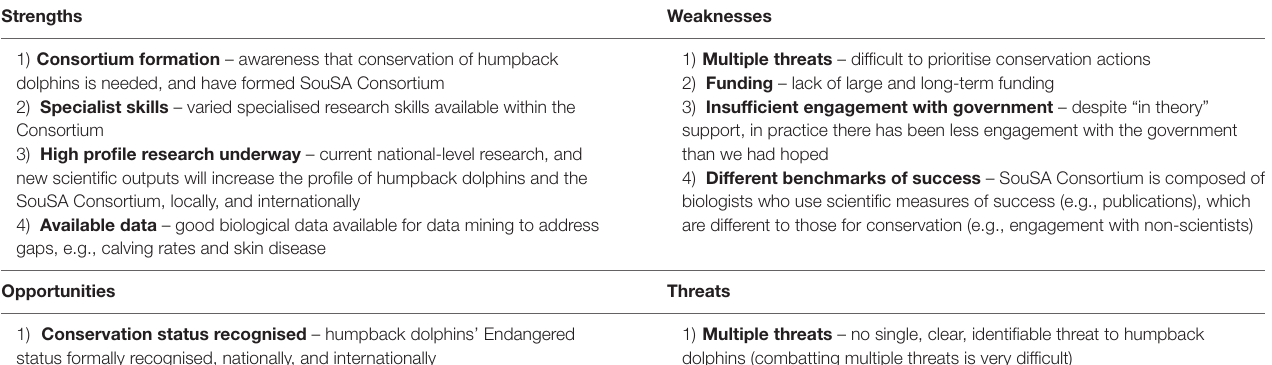
TABLE 1 | Definitions of the four categories that Strengths, Weaknesses, Opportunities, and Threats statements fell into/pertained to. G = Governance: formal and informal structures in place, e.g., national government, legislation, consortium, international organisations L = Logistics: financial, human capacity, physical (boats, access to areas) K = Knowledge: includes research, public knowledge, and awareness E = Ecological: inherent habitat and species-specific factors that influence progress TABLE 2 | Factors of the SWOT with an average rank >